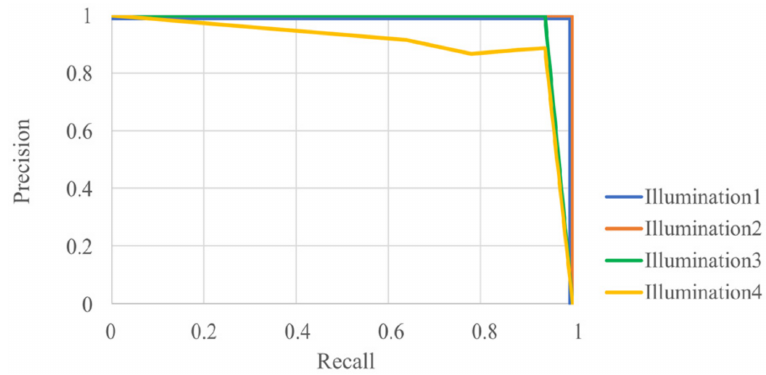
Figure 25. The P-R curve of VggNet under different illuminations.